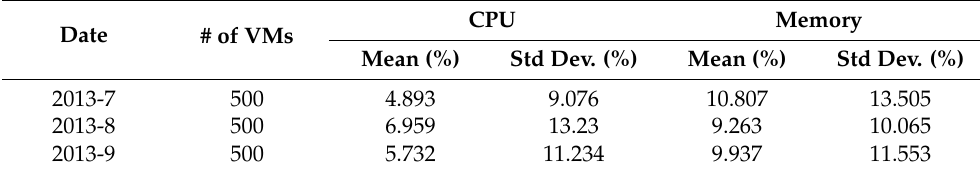
Table 3. Properties of Bitbrains trace